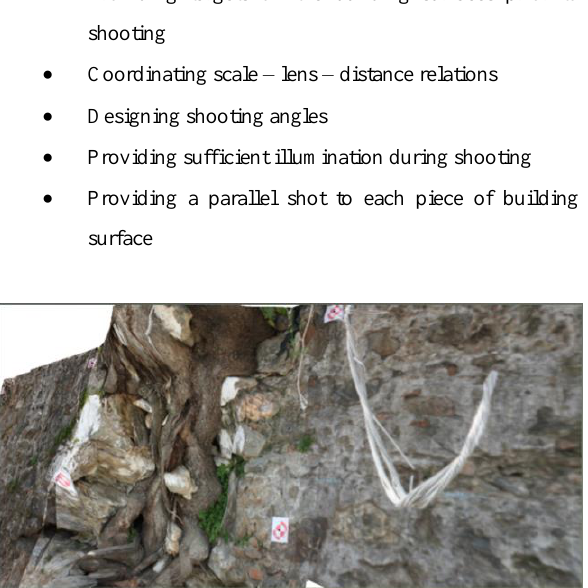
Figure 10. Presentation of photorealistic details of historical morphologies.